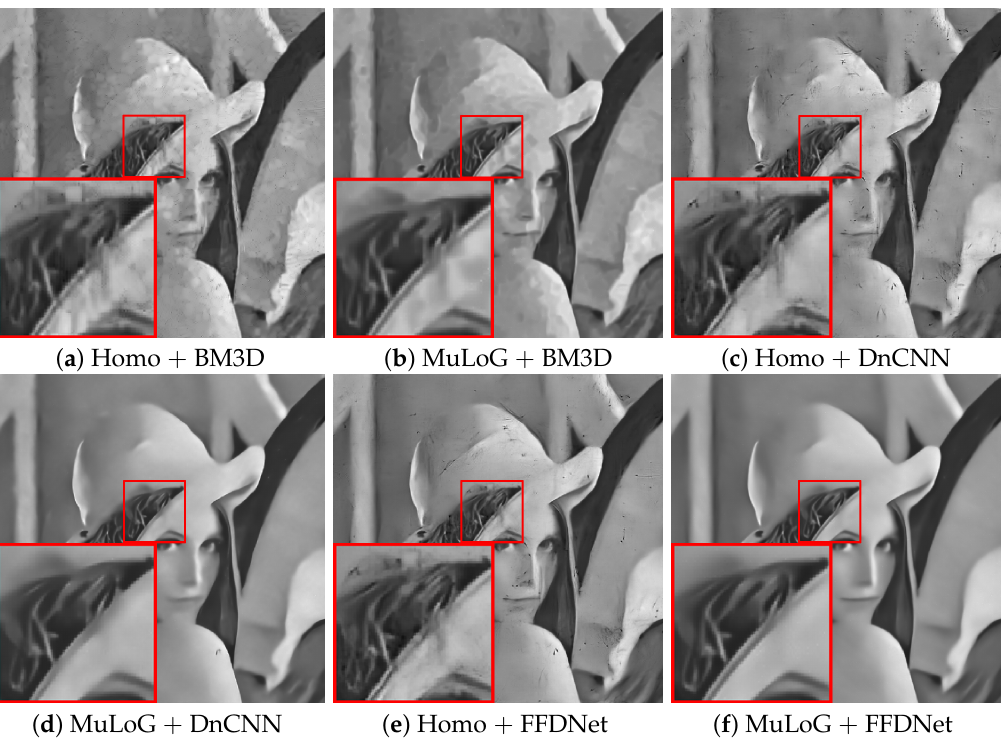
Figure 6. The denoising results for simulated SAR image with L = 1: ( a – f ) Homo + BM3D, MuLoG + BM3D, Homo + DnCNN, MuLoG + DnCNN, Homo + FFDNet, and MuLoG + FFDNet, respectively.